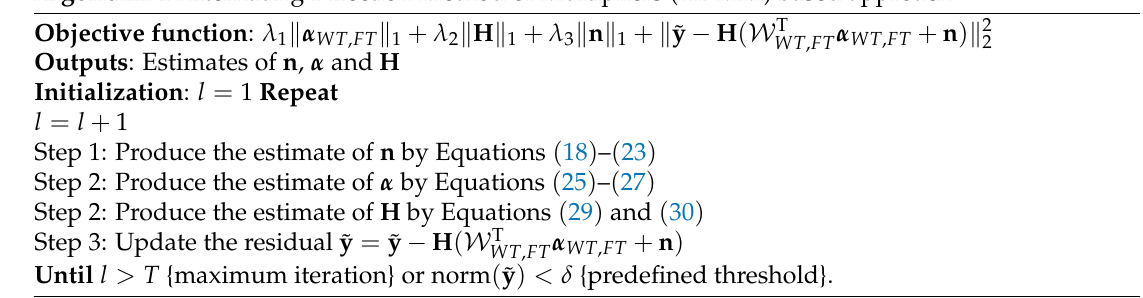
Algorithm 1 Alternating Direction Method of Multipliers (ADMM) based